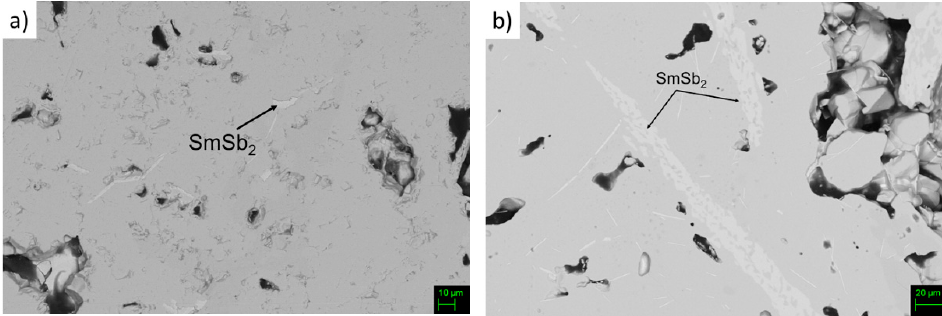
Figure 2. BS-SEM microphotograph of the polished surface of sample ( a ) Fe63 and ( b ) Fe70.